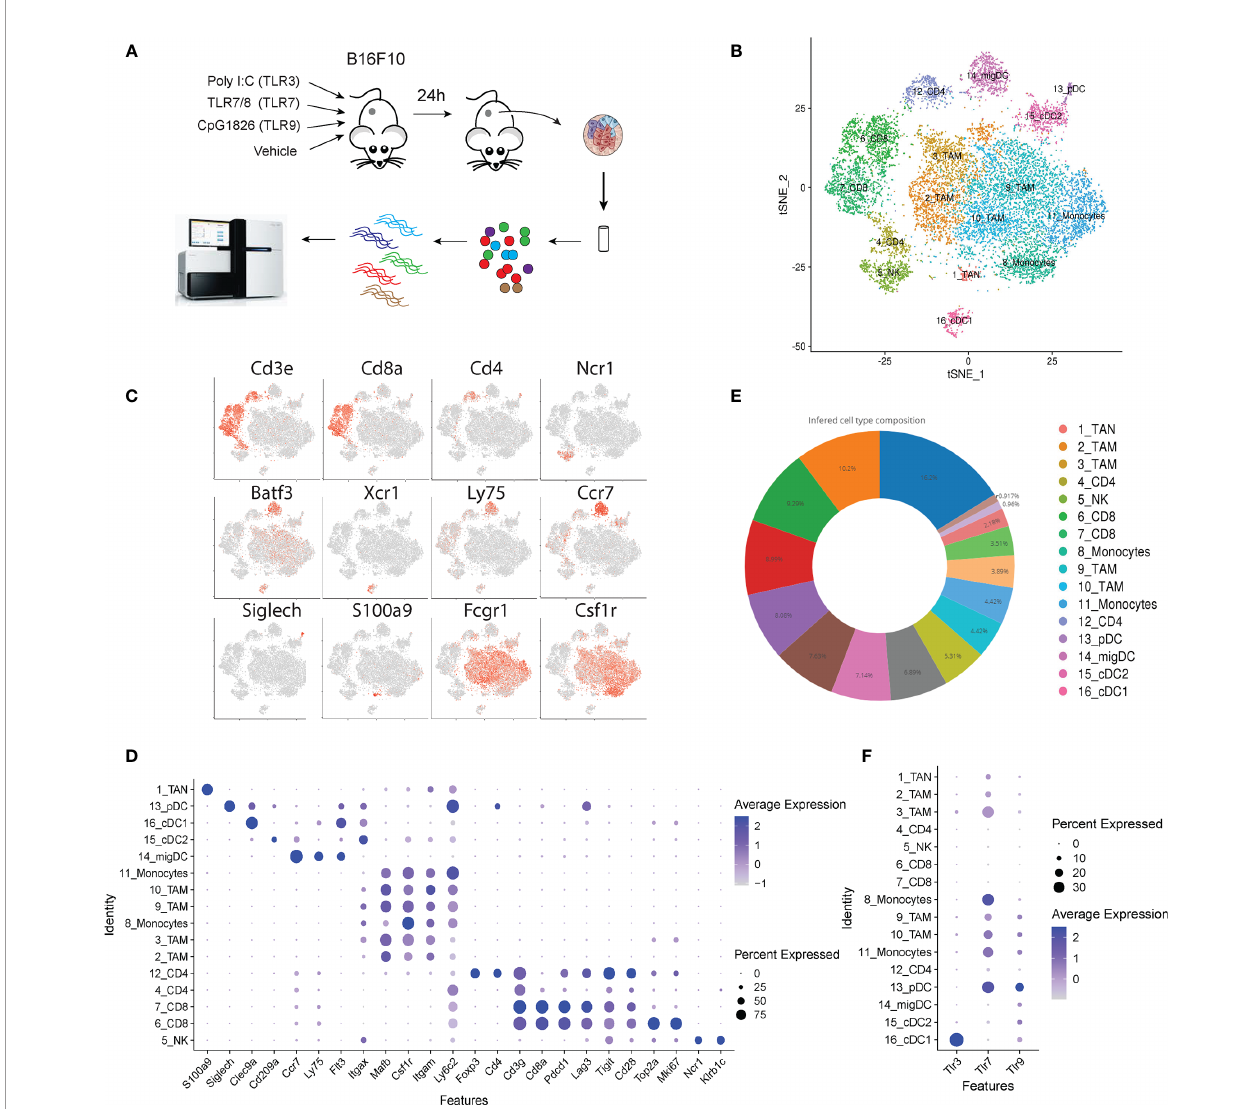
FIGURE 1 | Schematic overview of experiment. (A) B16F10 tumors were grown to ~150 mm 3 and intra-tumorally injected with TLR agonists. 24 hours post injection tumors were harvested and prepared for scRNA-Seq to pro fi le tumor immune landscape following treatment. (B) tSNE plot showing the presence of tumor associated immune cell subsets identi fi ed by scRNA-Seq. (C) Gene expression intensities for key lineage marker genes plotted on tSNE biaxial plot demarcating major T cell ( CD3e, CD4, CD8a ), NK cell ( Ncr1 ) dendritic cell ( Batf3, Xcr1, Ly75, Ccr7, Siglech ) neutrophil ( S100a9 ) and macrophage ( Fcgr1, Csf1r ) subsets. (D) Dot plot showing expression distribution of a wider panel of phenotypic markers for major immune cell subsets identi fi ed in (C) . (E) Pie chart showing the frequency distribution between cells in clusters identi fi ed in (B) across all tumor samples. (F) Dot plot showing the expression of Tlr3 , Tlr7 and Tlr9 genes in tumor-in fi ltrating CD45 +